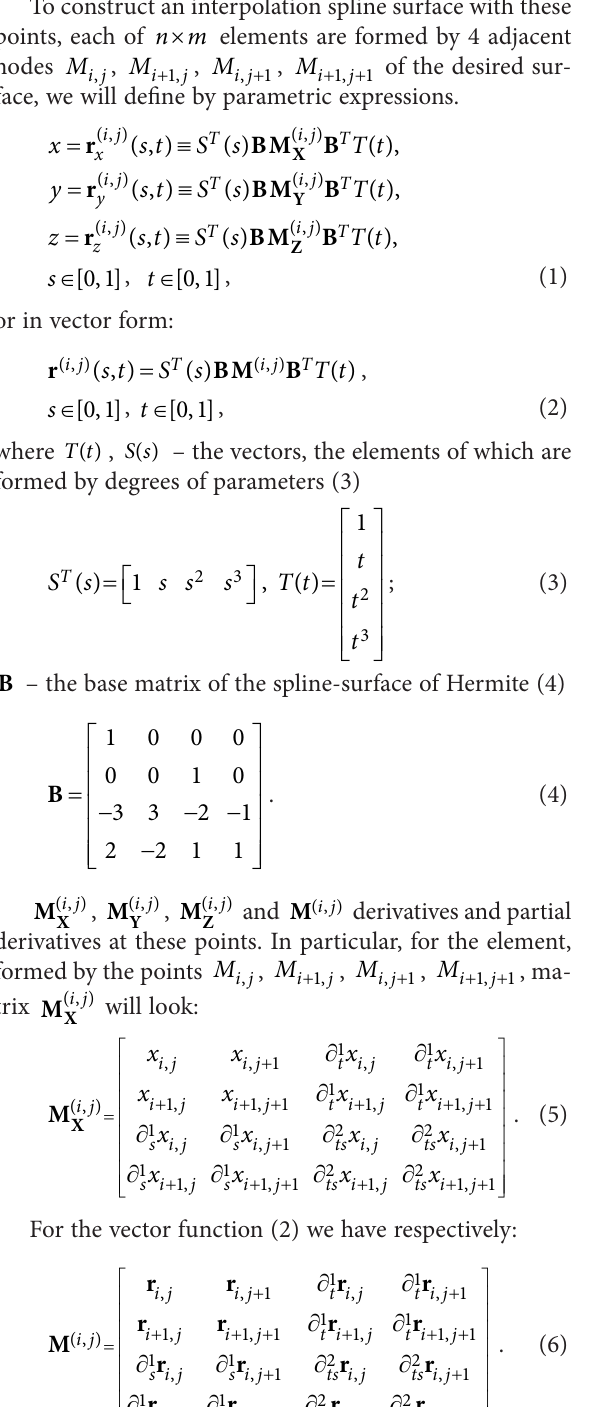
Figure 3. Tacheometric traverse around the